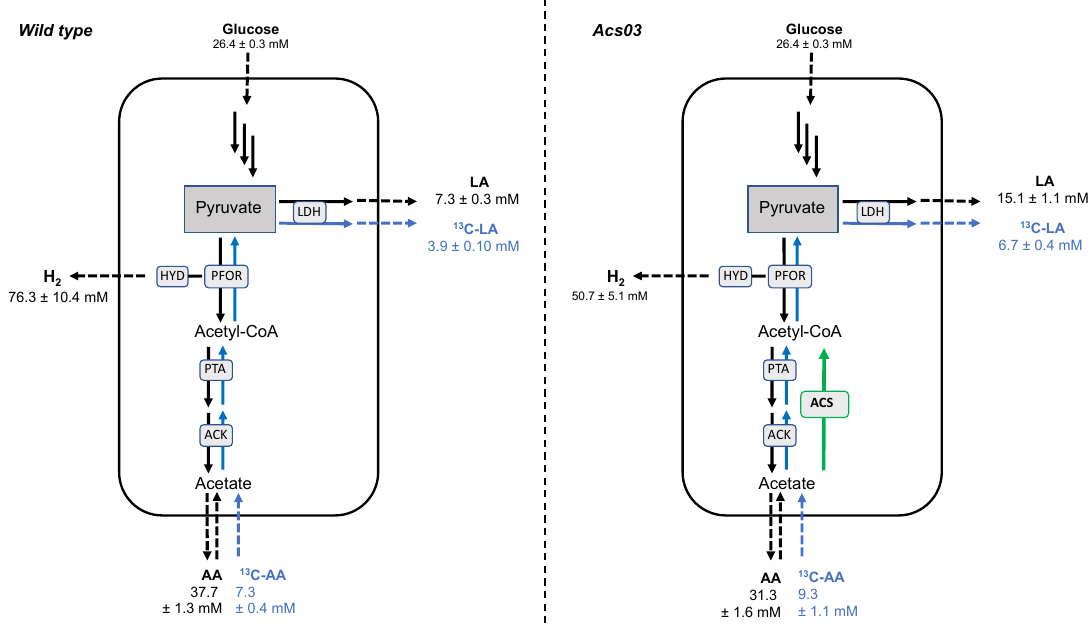
Figure 3. Capnophilic Lactic Fermentation (CLF) flow using 28 mM glucose and 20 mM 2- 13 C-acetate in the wild type and Acs03 recombinant strain. Unlabelled lactate (LA) derived from catabolic pyruvate (glycolysis) and anabolic pyruvate produced by coupling reaction of CO 2 and unlabelled acetate (AA) produced by fermentation. 2- 13 C-acetate ( 13 C-AA) is internalized and metabolized to 3- 13 C-lactate ( 13 C-LA). ACK, acetate kinase; PTA, phosphotransacetylase; ACS, acetylCoA synthetase; PFOR, pyruvate:ferredoxin oxidoreductase; LDH, lactate dehydrogenase; HYD, hydrogenase. Green arrow indicates ACS heterologous insertion. Data are expressed as mean ± SD, n = 3.